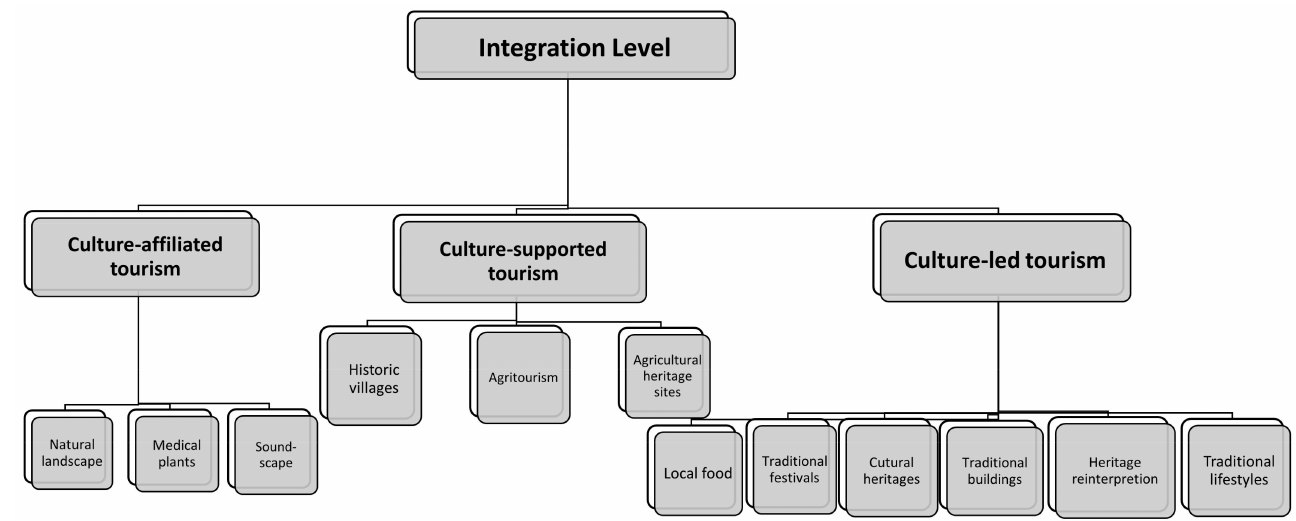
Figure 4. Three integration levels of cultural considerations in rural